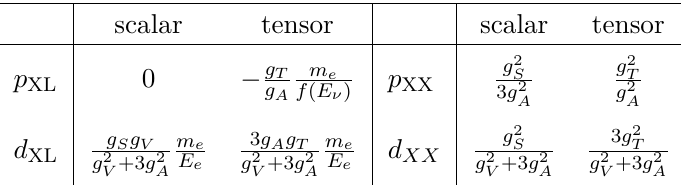
Table 1 . Production and detection factors, eq. (2.7) for reactors anti-neutrinos. Here E e is the positron energy, m is the electron mass and f ( E ) take in to account the nuclear fuel [46] and e ν sub-products in the reactor model, and the g and g were extracted from refs. [59–61]. A , g V , g T S For low-energy, the positron energy can be related to the electron antineutrino by the relation is the mass difference between the final and initial nucleon. E e = E ν − ∆ fi , where ∆ fi = m N − m N i f